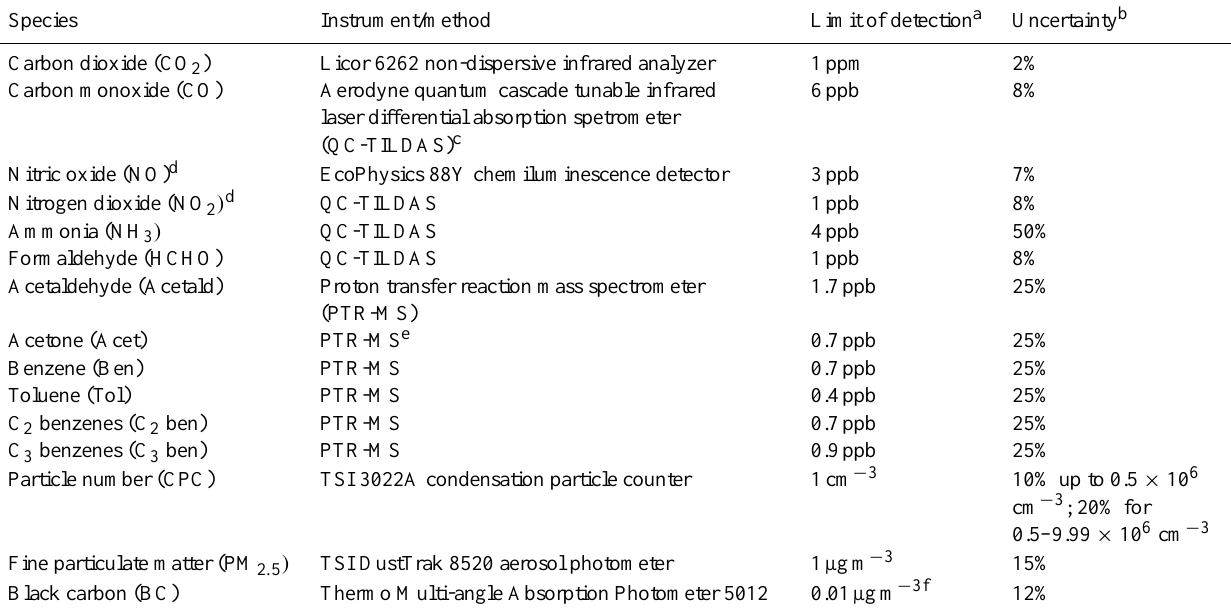
Table 1. Species used in the positive matrix factorization and their limits of detection and relative uncertainties during mobile measurements with the